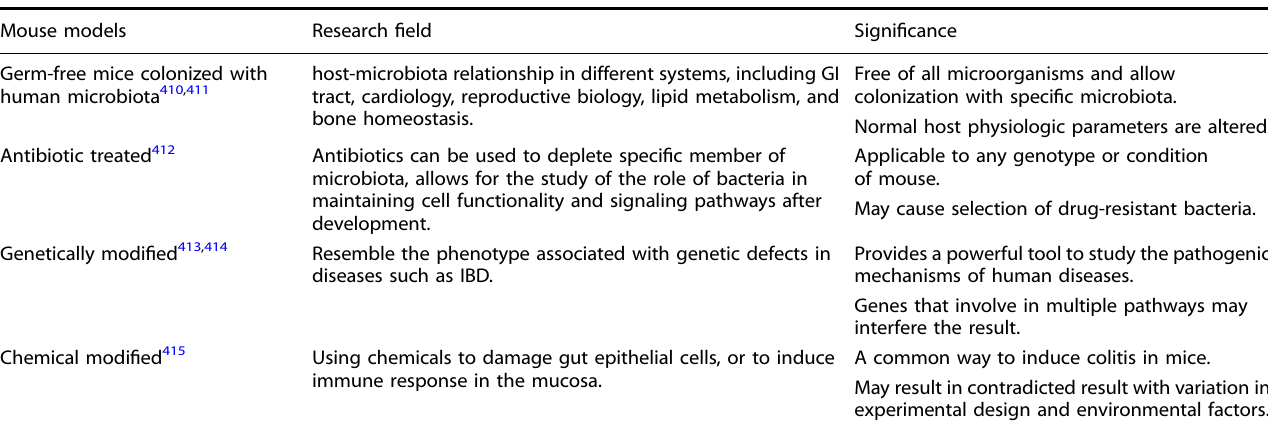
Table 1. Mouse models in microbiota research Mouse